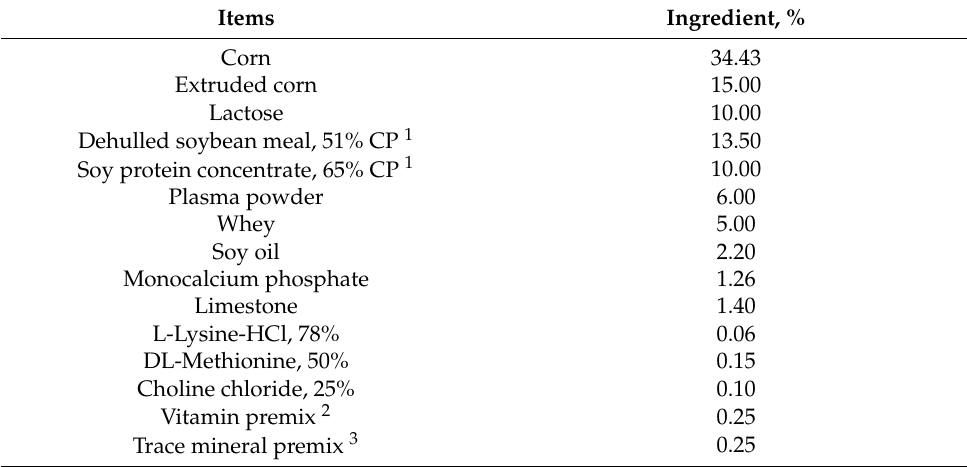
Table 1. Compositions of the basal weaning diets (as-fed